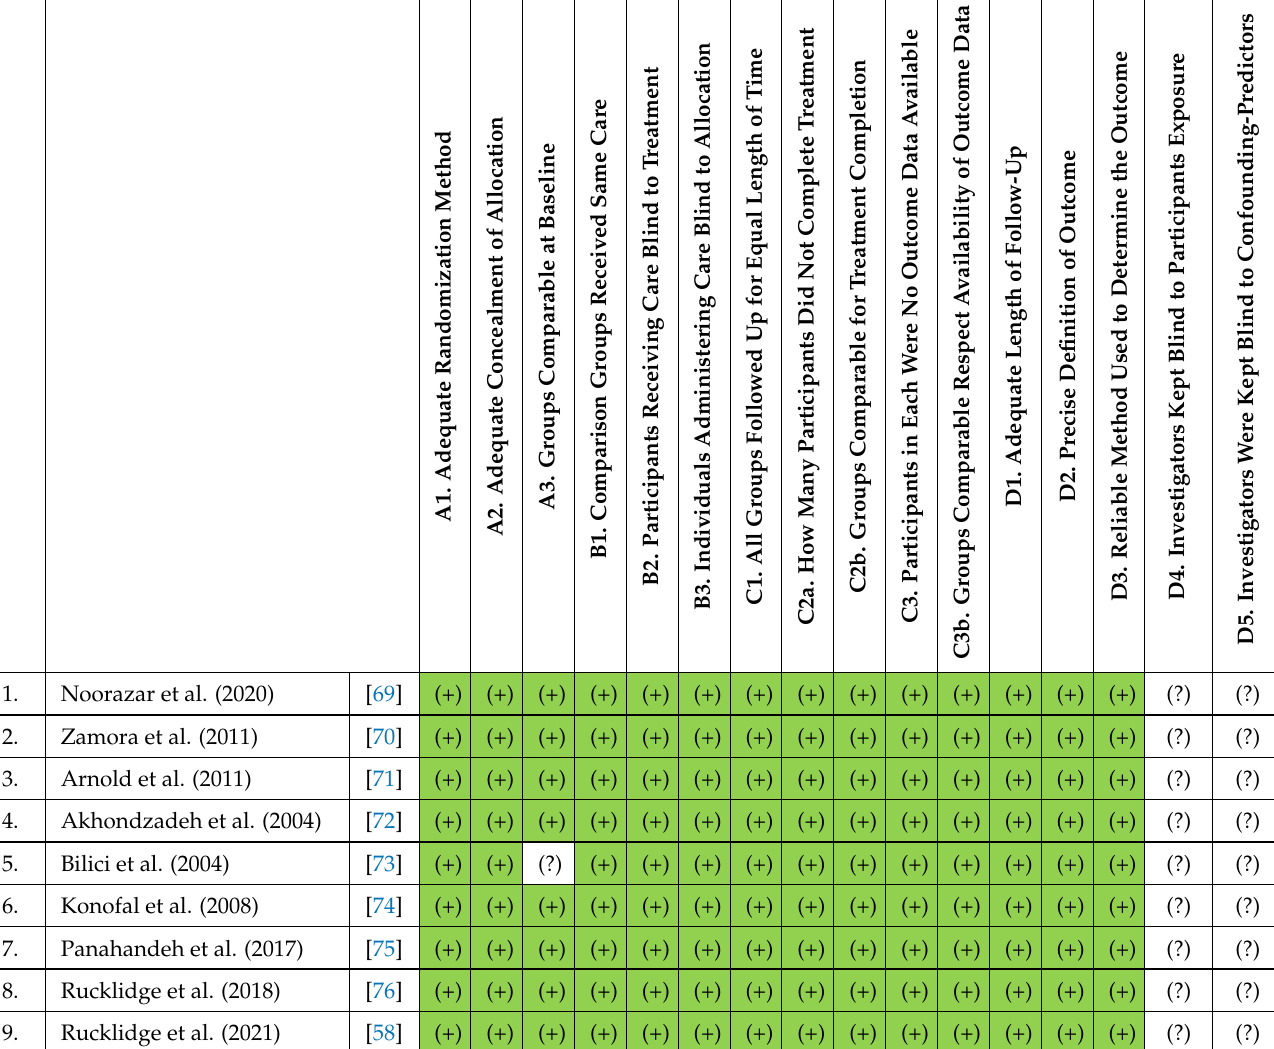
Table 3. Assessment of the studies’ quality based on the NICE